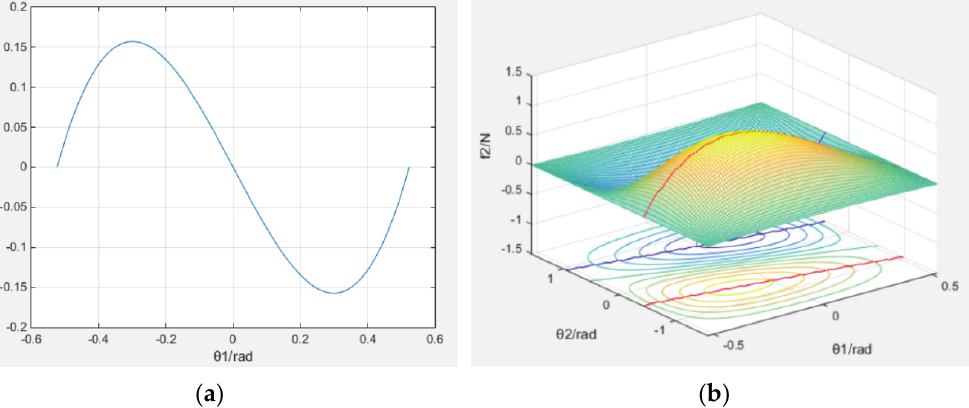
Figure 2. Relationship between fishtail thrust and joint angle. ( a ) Fishtail thrust—joint 1 angle. ( b ) Caudal fin thrust—joint 1 rotation and joint 2 rotation.